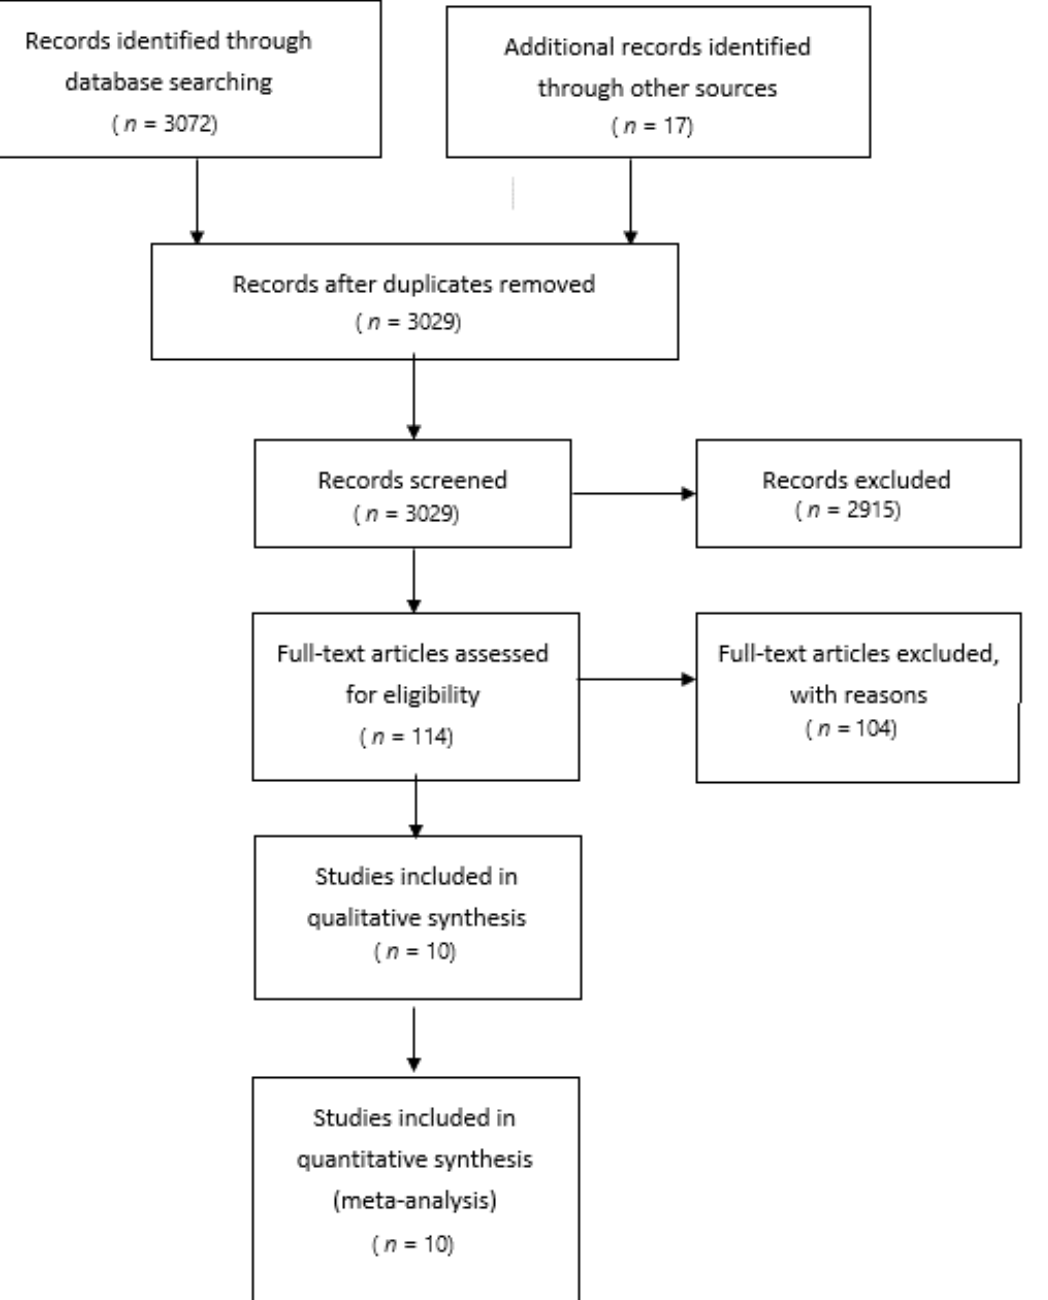
Figure 1. Systematic review flow diagram.